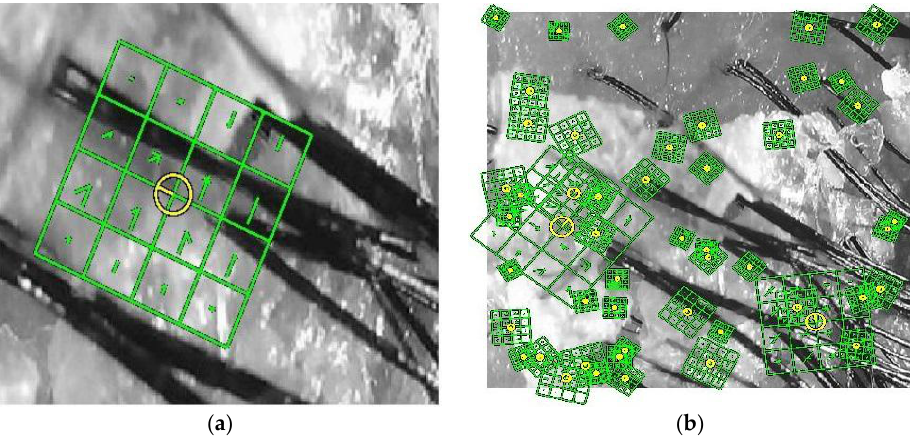
Figure 15. ( a ) Gradient magnitude and orientation of a key point; ( b ) gradient magnitude and orientation of all key points found.